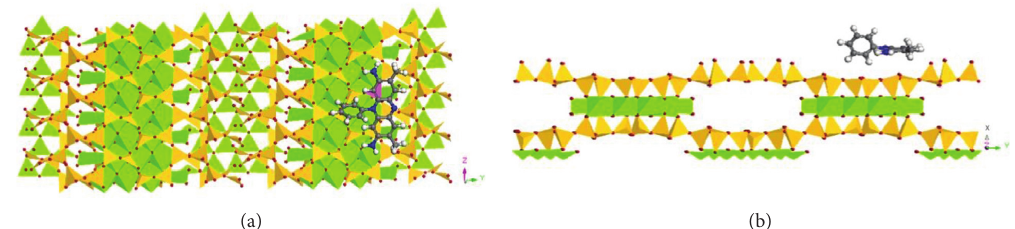
Figure 8: Molecular dynamic simulation showing SO uptake on the {100} surface (a) and projection along [001] (b) of SEP with 1 Si replaced with 1 Al in the supercell.